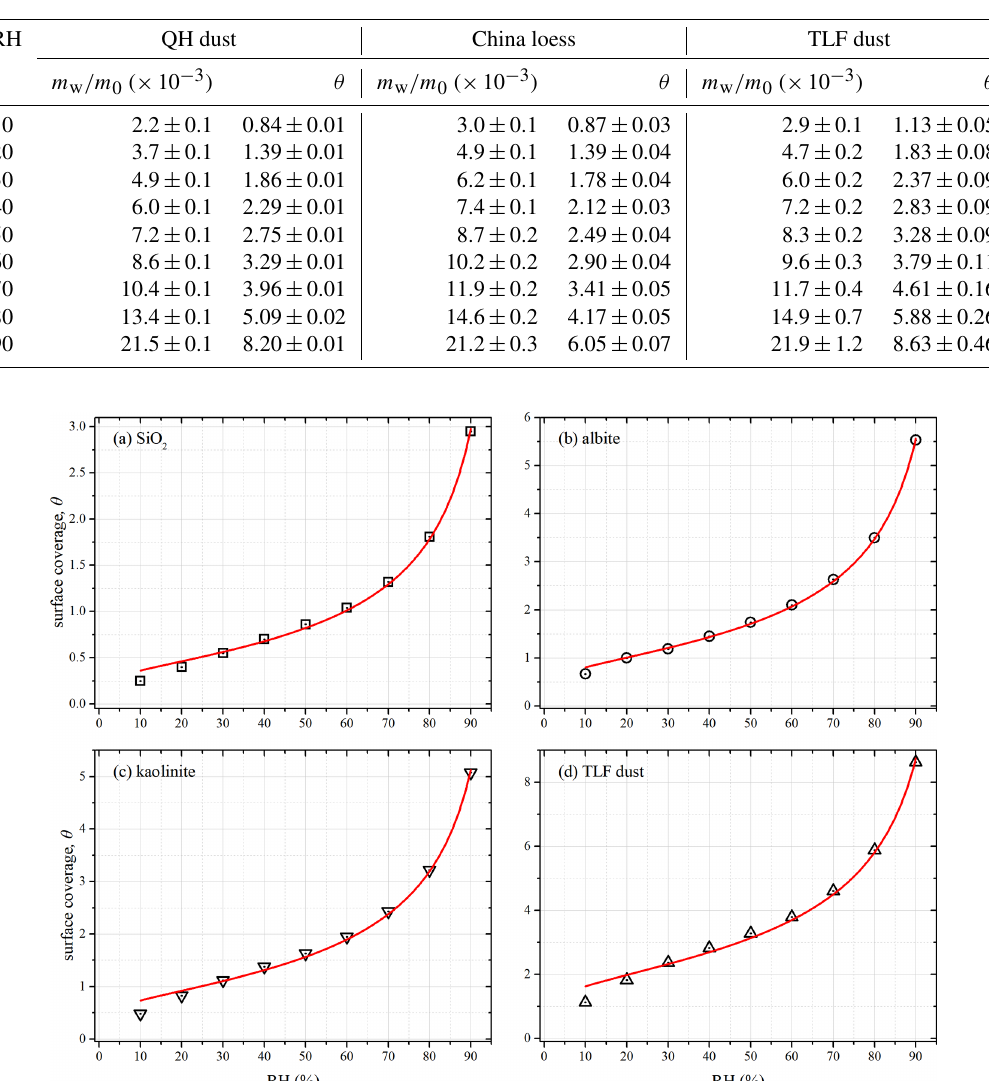
Figure 10. Surface coverages ( θ ) of adsorbed water on (a) SiO 2 , (b) albite, (c) kaolinite and (d) TLF dust as a function of RH (0%–90%) at 25 ◦ C. The experimental data were fitted with Frenkel–Halsey–Hill adsorption isotherm model (solid curves).